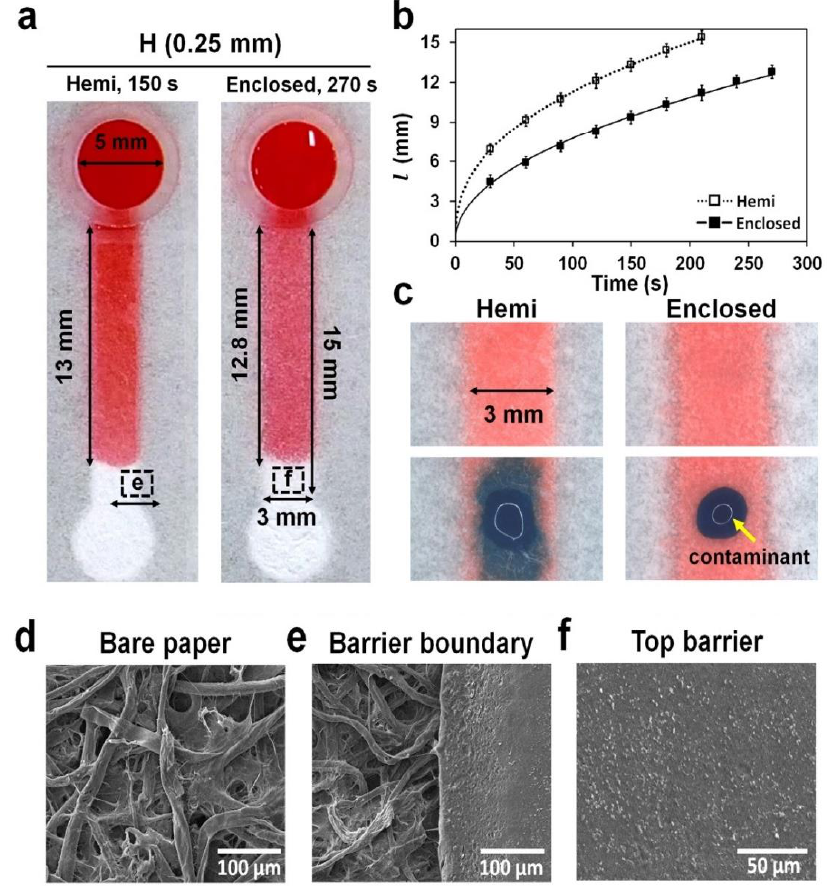
Figure 4. Wicking and contamination in hemi and enclosed channels. ( a ) The top view of both channels stained with 30 μL of a red dye solution from the reservoir in the 3D-μPADs. The images of hemi and enclosed channels (15 mm long) were taken at 150 and 270 s, respectively, when the solution head traveled approximately 13 mm from the reservoir. Red dye in the enclosed channel was also visible, such as the one in the hemi channel, because the top barrier in the enclosed channel was semi-transparent. ( b ) The wicking distance ( l ) of the dye solution was measured at different times (0–270 s) in the hemi channel (empty square) and the enclosed channel (square). n = 3. ( c ) Dispersion of a blue dye solution (1 μL) dropped onto the top of both channels, simulating contamination of the channel. ( d – f ) SEM images: ( d ) the bare paper, ( e ) barrier boundary in the hemi channel ( a ), and ( f ) top barrier in the enclosed channel ( a ).